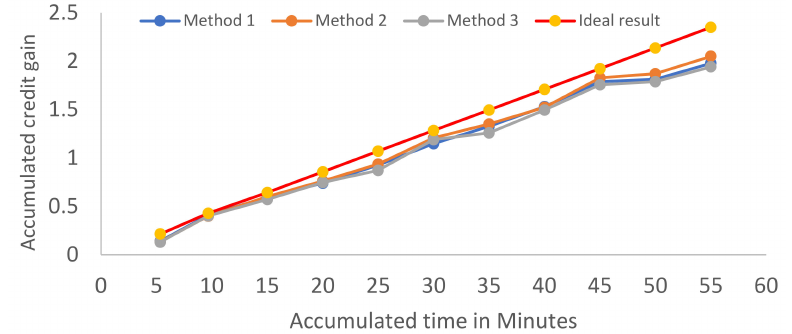
Figure 4. Comparison of the three methods used to calculate credits over 60 min.